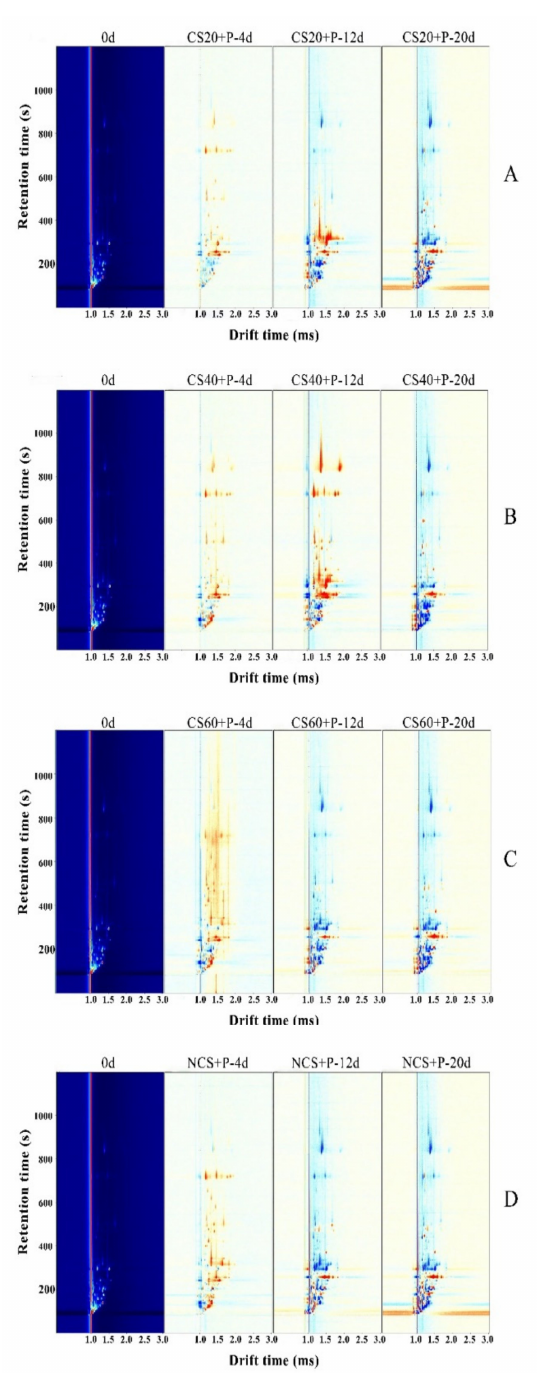
Figure 7. Comparison of the two-dimensional difference spectra of volatile organic compounds GC–IMS in cucumbers under different treatments ( A ): CS20+P; ( B ): CS40+P; ( C ): CS60+P; ( D ): NCS+P.CS20+P − packaged after 20 min of cold shock; CS40+P − packaged after 40 min of cold shock; CS60+P − packaged after 60 min of cold shock; NCS+P − packaged after 0 min of cold